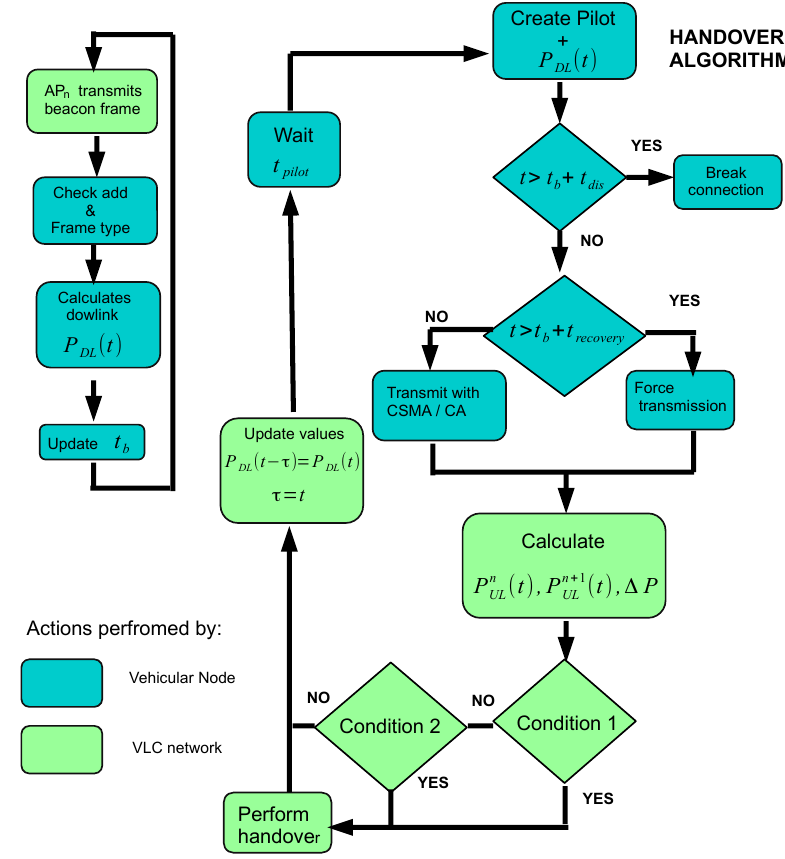
Figure 8. Diagram of handover decision algorithm.